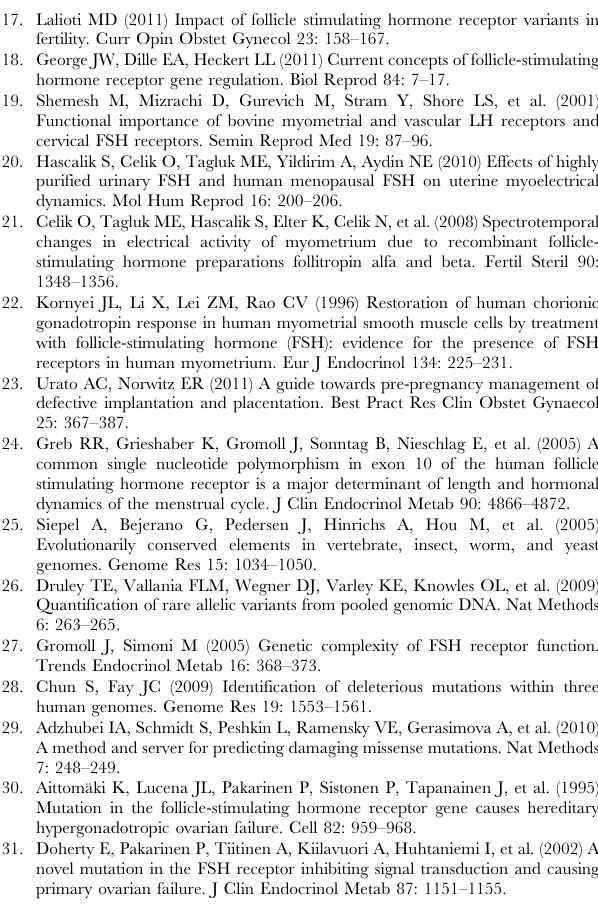
Table S1 Rare SNVs ( , 5%) observed in either cases or controls but not both. Table S2 Genotypes of SNPs tagging protective and risk haplotypes. Table S3 Rare SNVs exclusively found in cases and located at conserved or nonsynonymous sites. Table S4 Genomic regions selected for sequencing. Table S5 PCR parameters used to amplify candidate regions. Table S6 Genotypes of 12 SNPs across the case/control